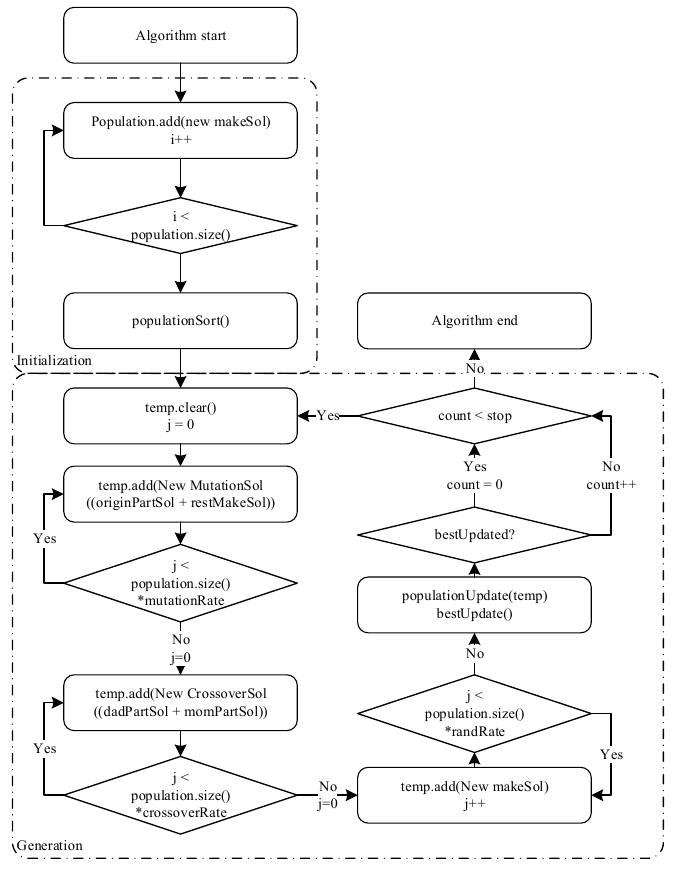
Figure 4. The flowchart of GA.